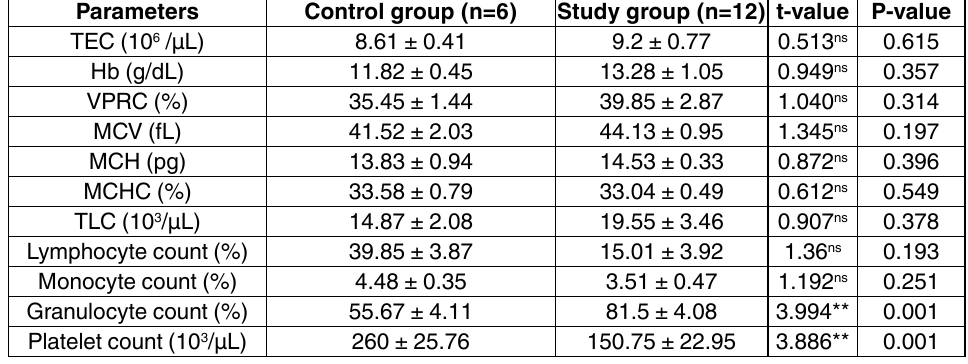
table 1. Comparison of haematological parameters between control group and study group Parameters